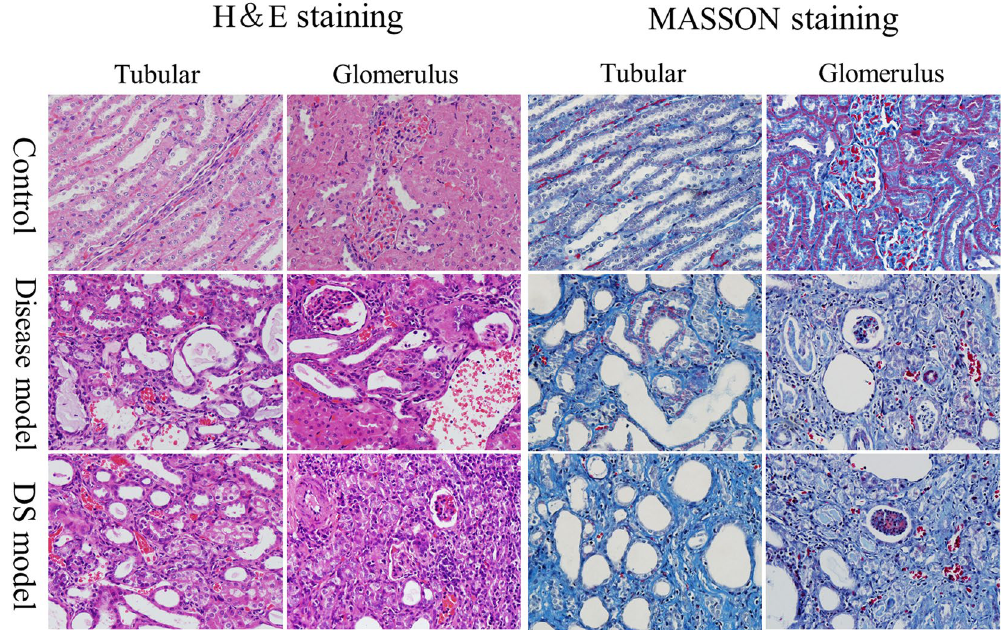
Figure 2. H& E and Masson staining on kidney tissue of rats in control, disease and DS groups. H& E staining: rats in disease and DS groups were observed with renal cortex and medulla atrophied, glomerular sclerosis and atrophy, renal tubular expansion, structure diffusion, visible hyalinization, protein tube and a large number of cavity; Glomerular and capillary congestion and clear inflammatory cell infiltration was also observed. Masson staining: glomerular basement membrane and tubule interstitial fibers proliferated significantly in disease and DS groups of